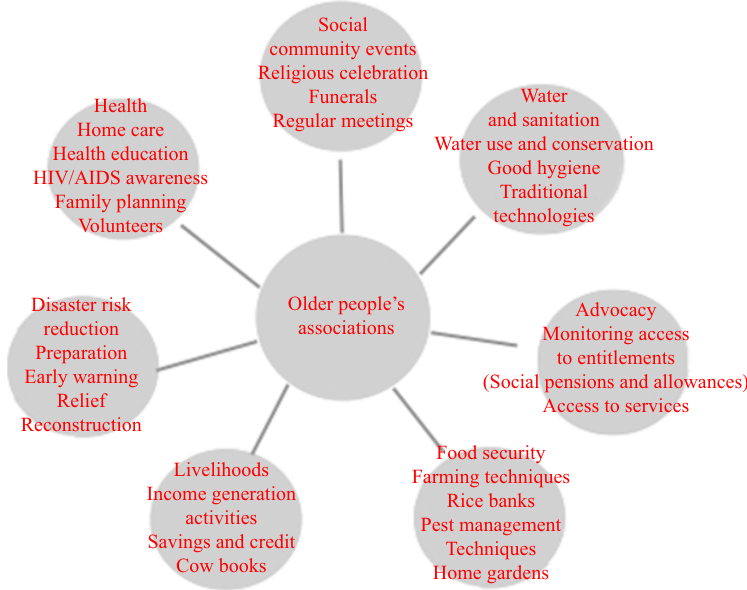
Figure 1. Older people ’